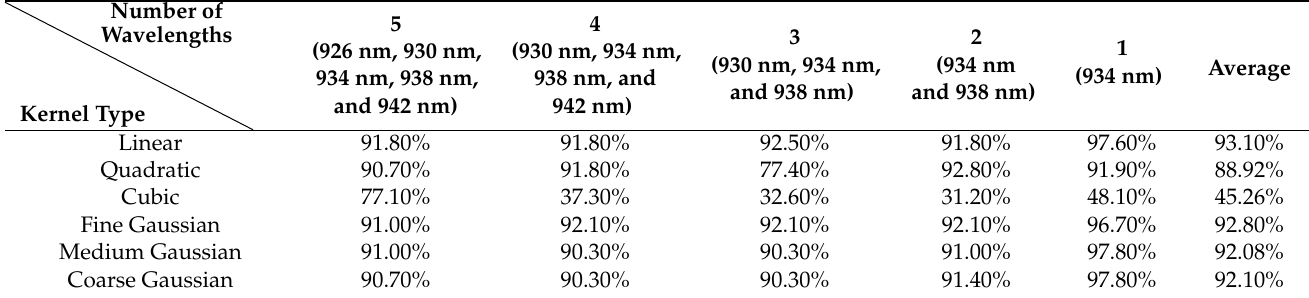
Coarse Gaussian Table 5. Performance of each SVM model for specificity in each reduction of the number of wavelengths.